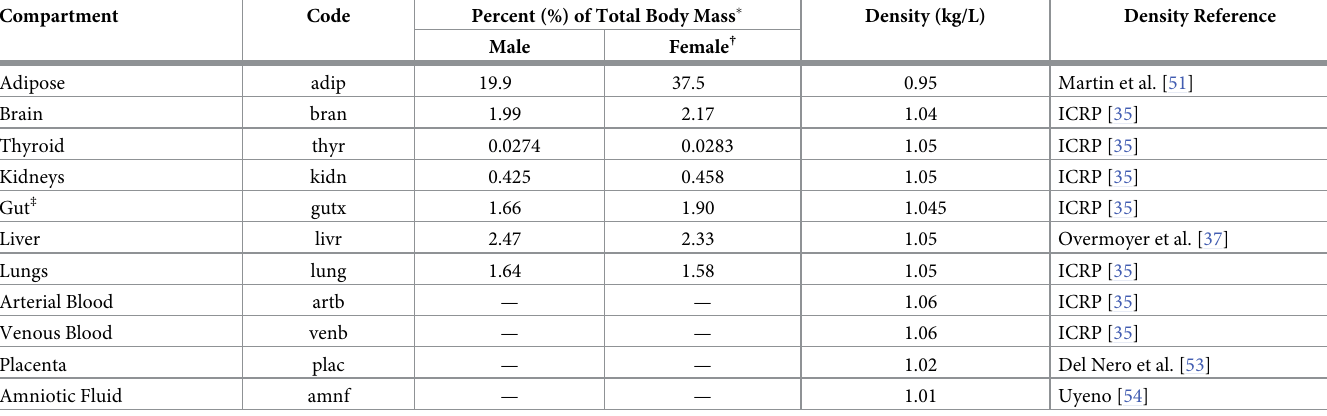
Table 8. Percent of total body mass and density (references listed) for various human organs and tissues.